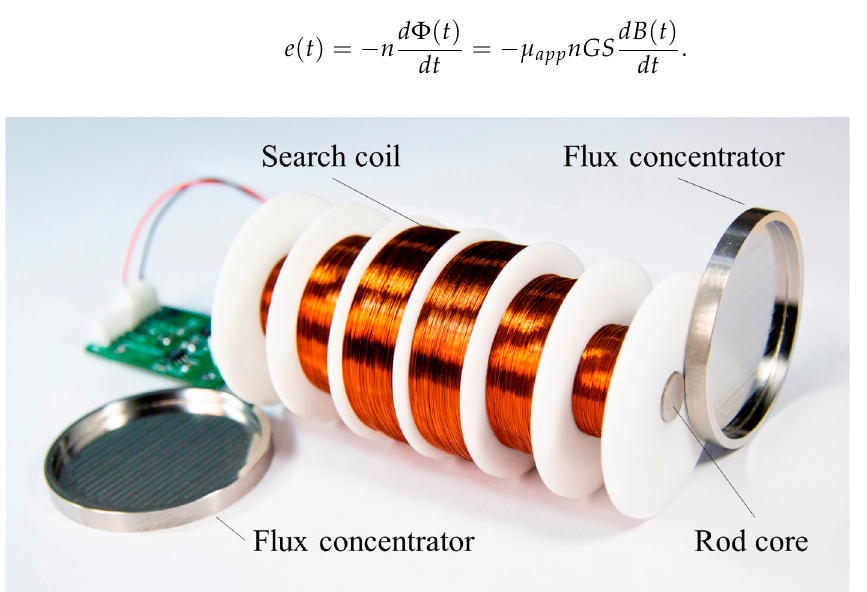
Figure 1. Experimental model of the search coil magnetometer.